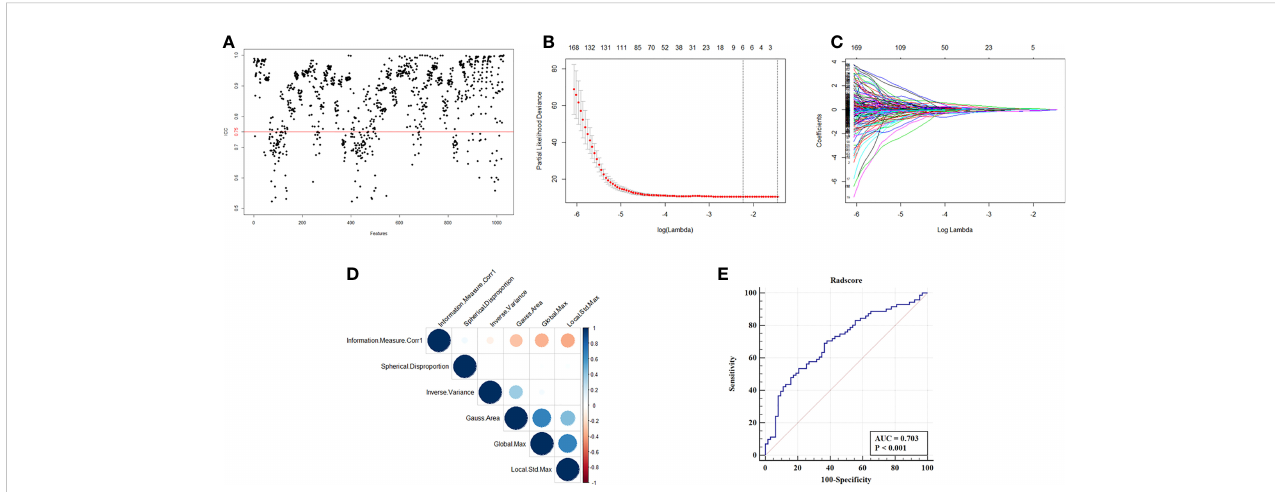
FIGURE 2 Selection of radiomics features and construction of Radscore. (A) ICC map of radiomics feature from two independent radiologist. (B) Partial likelihood deviance of radiomics features revealed by the LASSO-Cox regression model. The red dots represented the partial likelihood of deviance values, the gray lines represented the standard error (SE), the two vertical dotted lines on the left and right represented optimal values by minimum criteria and 1-SE criteria, respectively. Minimum criteria were used to select host radiomics features in model. (C) LASSO coef fi cient pro fi les of the survival-related radiomics features. (D) Correlation analysis of radiomics features selected by LASSO-Cox regression model. (E) ROC curve of Radscore with the AUC of